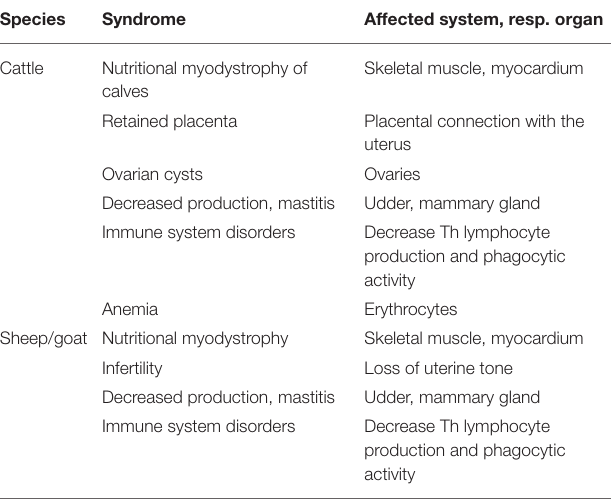
TABLE 2 | Overview of Se and vitamin E deficiency syndromes in